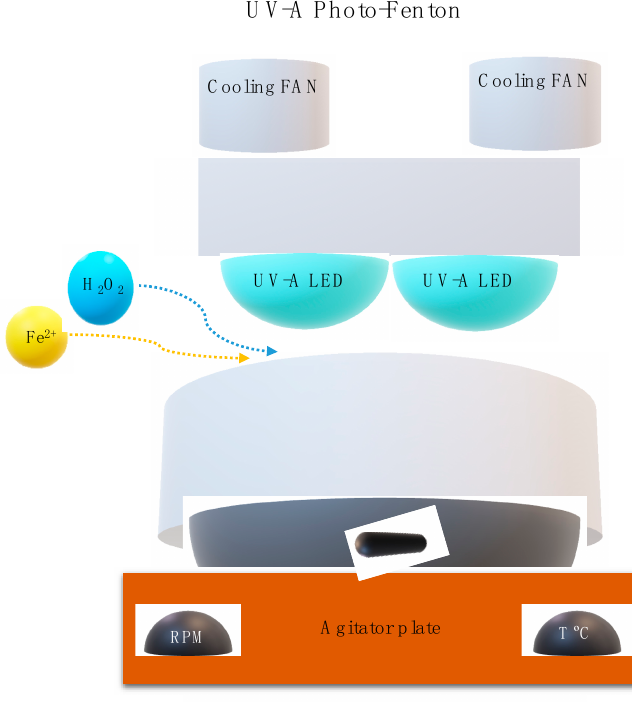
Figure 2. Photo-Fenton set-up schematic representation.